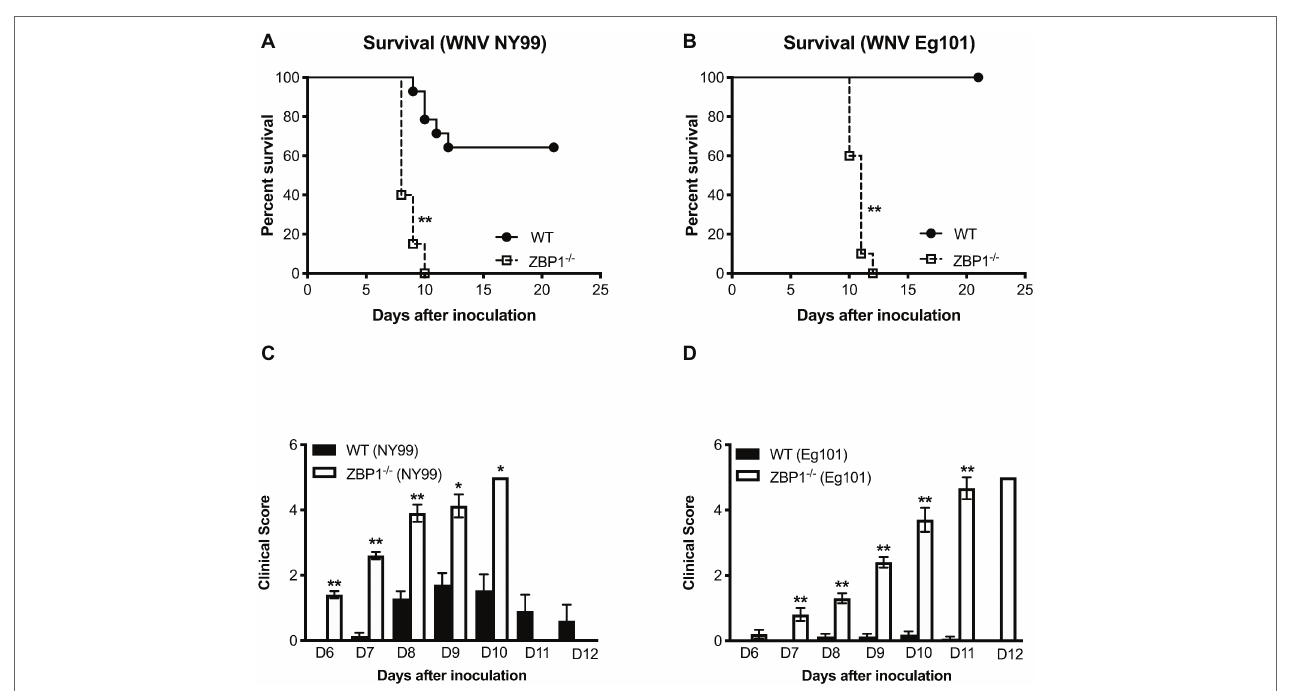
FIGURE 1 | Analysis of survival and clinical score in WT and ZBP1 −/− mice following WNV infection. WT and ZBP1 −/− mice were inoculated subcutaneously via footpad with (A) WNV NY99 (100 PFU) or (B) WNV Eg101 (1,000 PFU). The difference in the survival of WT and ZBP −/− mice was statistically significant for both WNV NY99 and WNV Eg101 ( n = 12–22 mice per group). (C,D) Animals were monitored twice daily for clinical signs. The designation for the clinical scores is as follows: 1, ruffled fur/hunched back; 2, paresis/difficulty walking; 3, paralysis; 4, moribund/euthanized; and 5, dead. Error bars represent SEM, * p < 0.05, ** p <